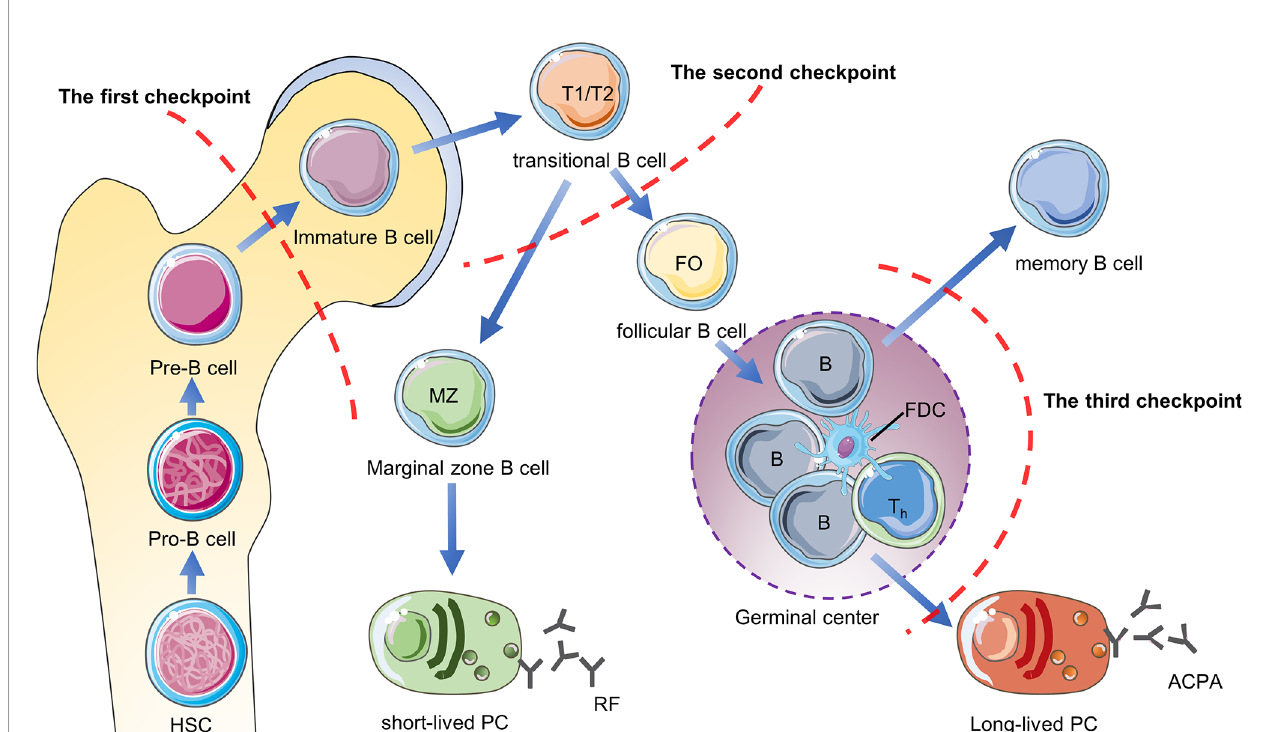
FIGURE 3 | B cell tolerance checkpoints in RA. B cell tolerance checkpoints are “ checkpoints ” to reduce the number of autoreactive B cells in RA patients. After these checkpoints are impaired, a large number of autoreactive B cells will accumulate in RA patients and cause the production of autoantibodies such as RF and ACPA. HSC, hematopoietic stem cells; PC, plasma